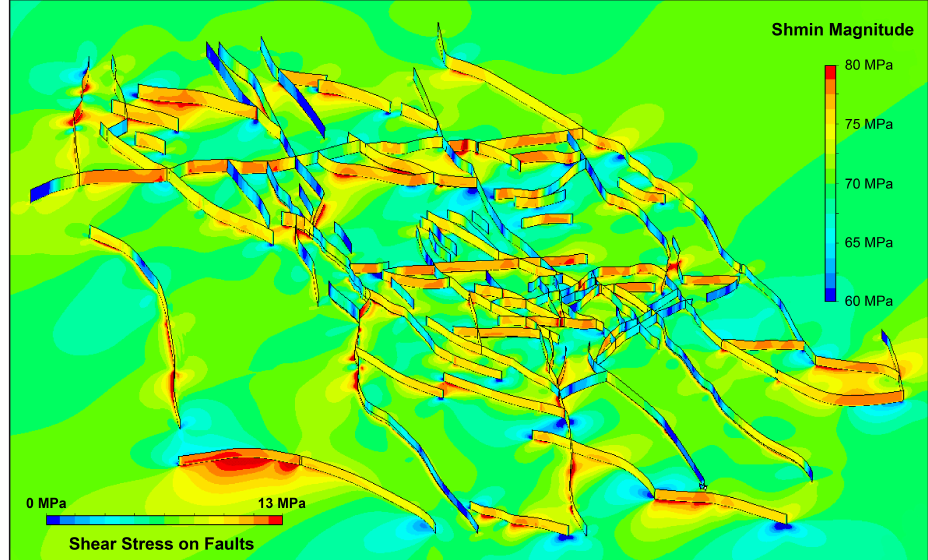
Fig. 5. Contour plot combining the reservoir-wide distribution of the magnitude of the minimum horizontal stress (Shmin) and the shear stress acting on the fault faces (both in MPa at mid-reservoir level). The plot illustrates that stress magnitude perturbations can range at least several hundreds of metres from the inducing fault. Some perturbations are induced by mechanically different layers juxtaposed to each other across the fault.